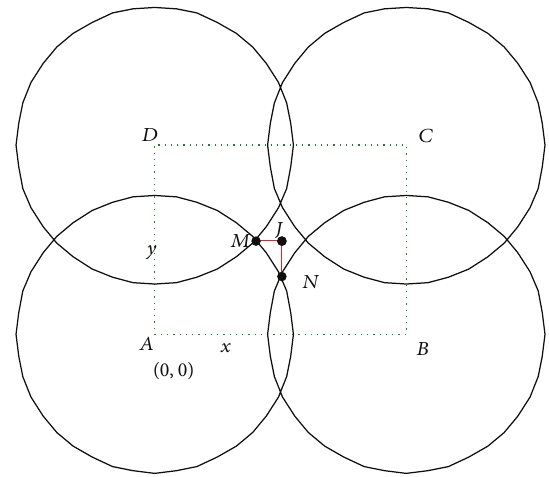
Figure 5: Case 3: relationship between 𝑥 and 𝑦